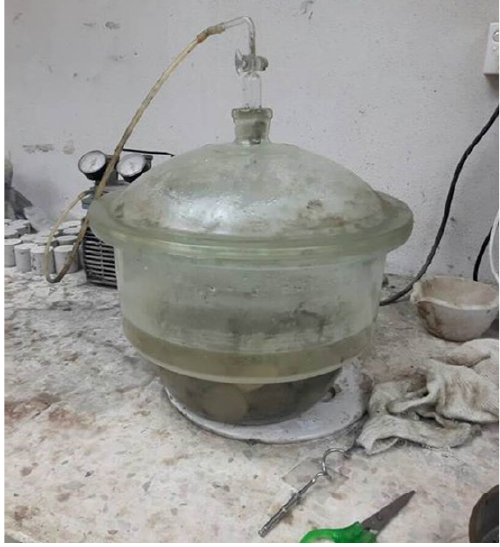
Figure 4. Vacuum saturation